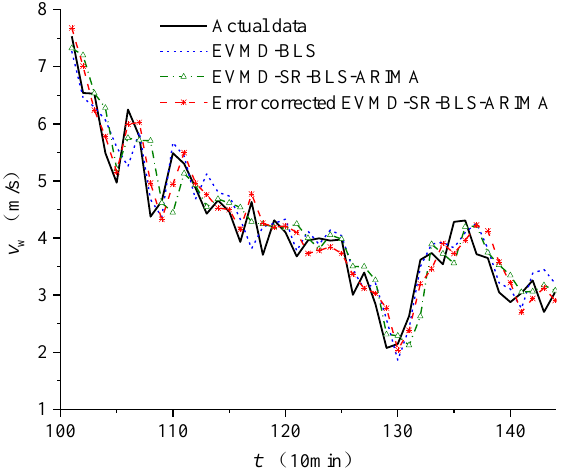
18 of 21 Figure 14. Subseries sample entropy of EVMD. In Figure 14, the horizontal axis u value of 0 represents the sample entropy of the undecomposed wind speed data, u 0 . The sample entropy values of each subseries u 1 ~ u 7 are 60.32%, 73.68%, 63.47%, 61.56%, 71.10%, 20.22% and 21.69% of the sample entropy value of u 0 , respectively, and the minimum sample entropy, En samp,min , is 0.299. The high- entropy-value subseries were screened as u